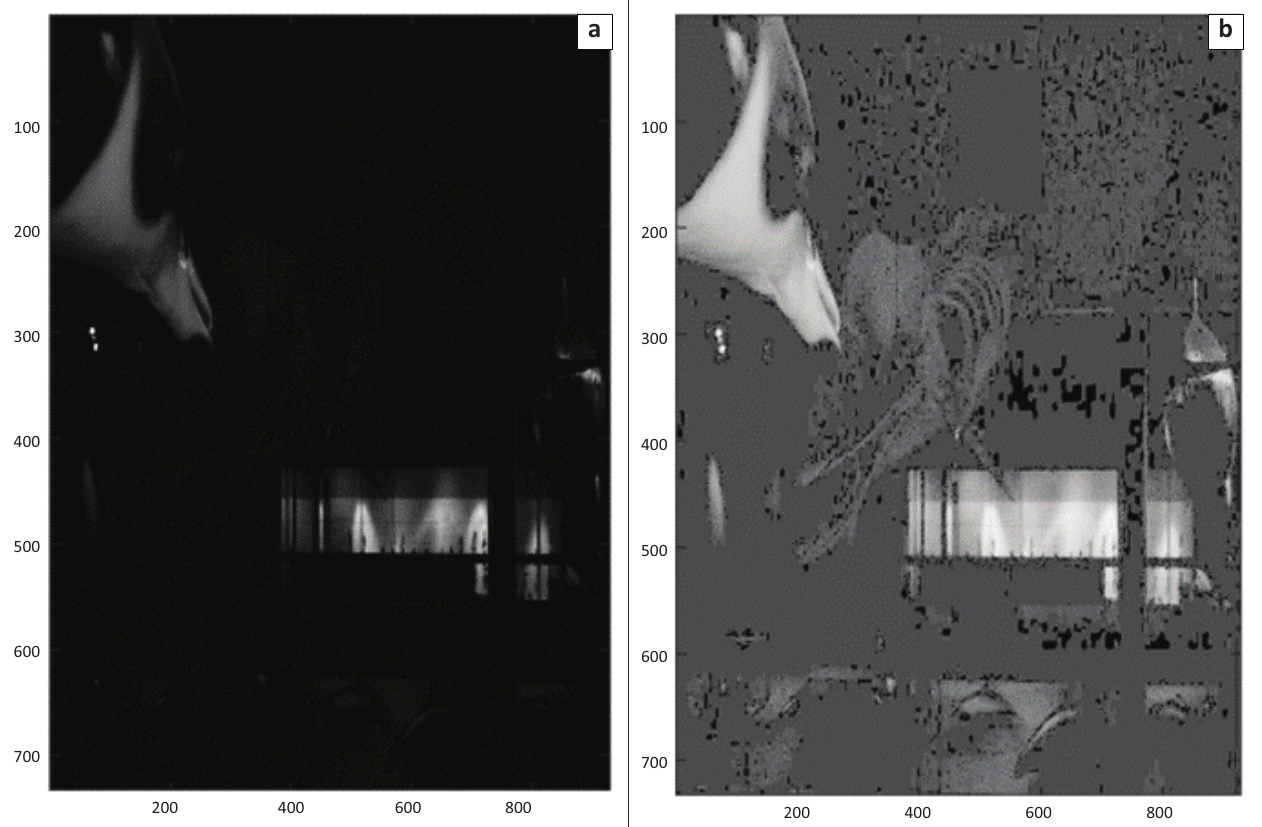
FIGURE 6: (a) Low contrast image. (b) Increased contrast after function